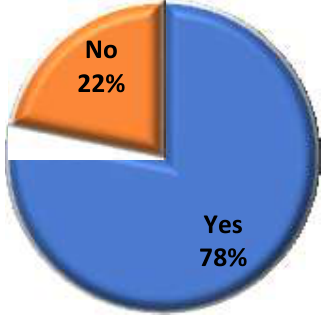
Figure 2. Quality of the natural resource (Source: Research data, 2019)